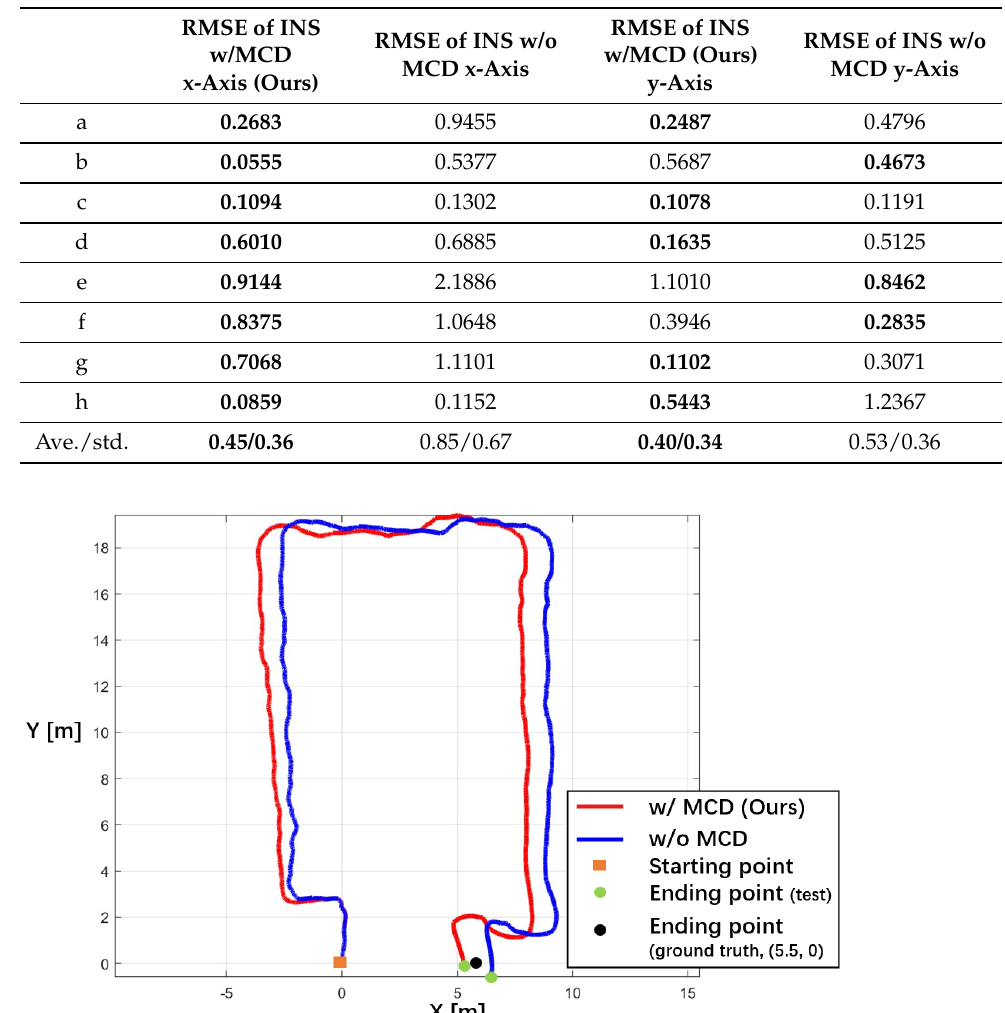
Table 6. Comparison of RMSE [M] of INS Trajectory with and without MCD Constraint for Scenario 3.